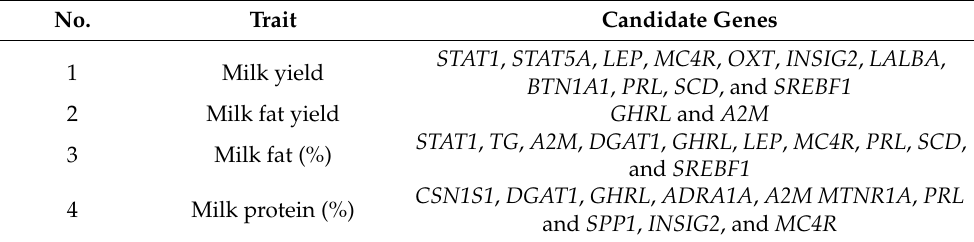
Table 2. Candidate genes associated with different milk yield traits.